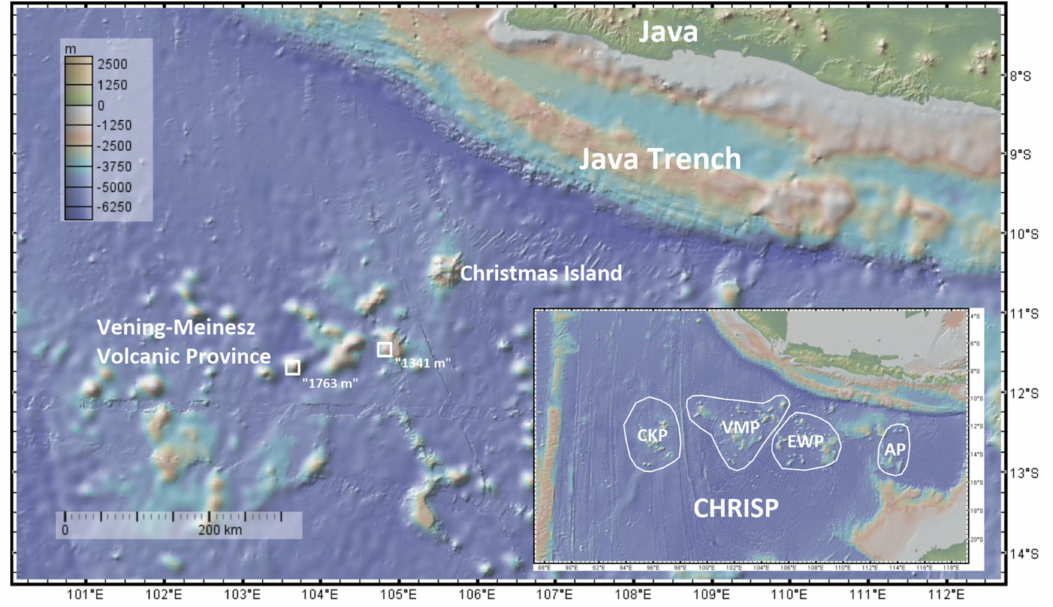
Figure 1. Bathymetric map of the NE Indian Ocean showing the location of Christmas Island. White squares show the locations of seamounts “1763 m” and “1341 m” of the Vening-Meinesz Volcanic Province (VMP). Inset shows the volcanic sub-provinces of CHRISP [10] as follows: AP, Argo Basin volcanic province; EWP, Eastern Wharton Basin volcanic province; VMP, Vening-Meinesz volcanic province and CKP, Cocos-Keeling volcanic province. Map generated by GeoMapApp [17]. In addition, Christmas Island has a young (lower Pliocene) rejuvenated lava series (the upper volcanic series UVS, [10]) significantly younger than an older (upper